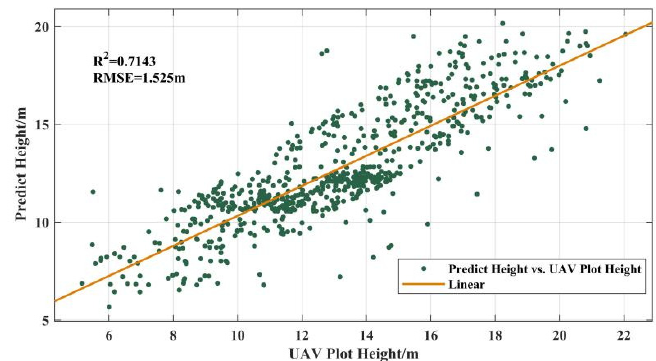
Figure 6. Canopy height prediction compare with UAV Lidar data.